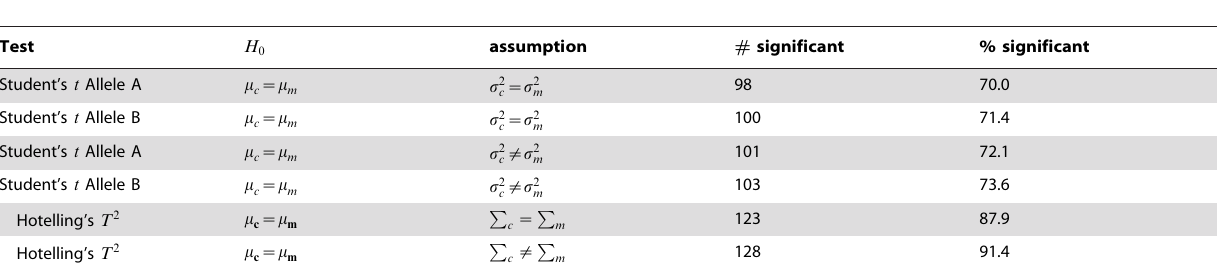
Table 1. Significance tests of equal mean intensities for missing and non-missing genotyping results.